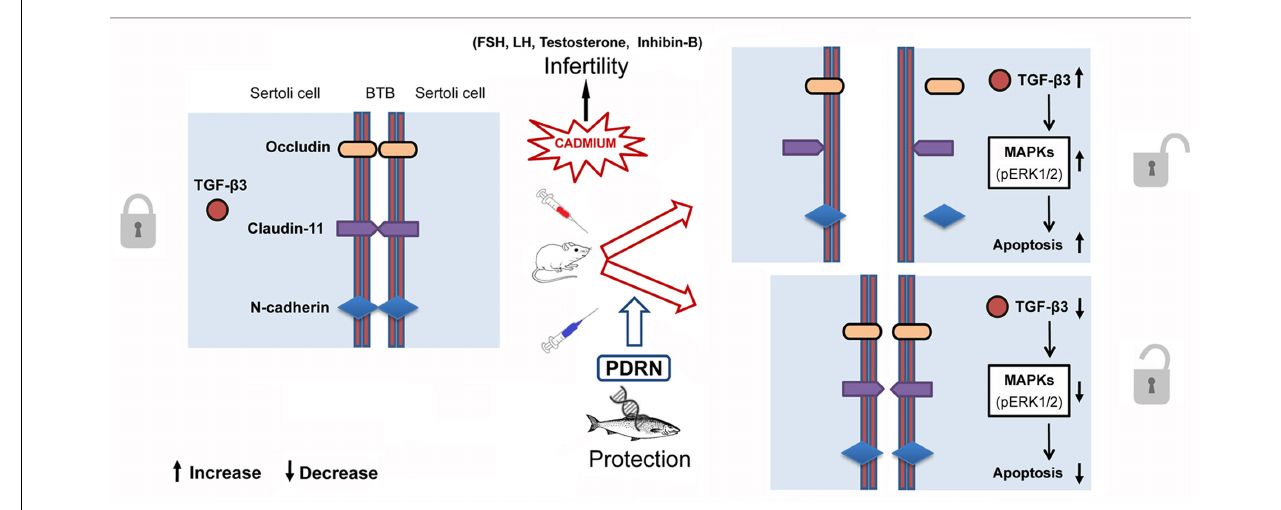
FIGURE 8 | Schematic representation of the suggested action mechanism of Cd and PDRN through the pERK 1/2/TGF- β 3 signaling pathway at level of Sertoli cells in mice.